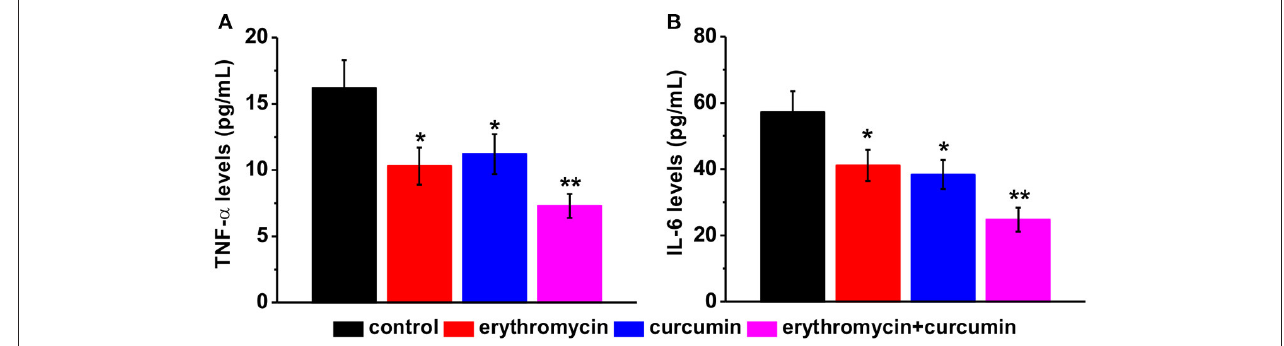
FIGURE 4 | Levels of pro-inflammatory cytokines in the serum of experimental rats after treatment, including TNF- α (A) and IL-6 (B) , measured by ELISA. Results were presented as mean ± SD * p < 0.05 and ** p < 0.01 vs.